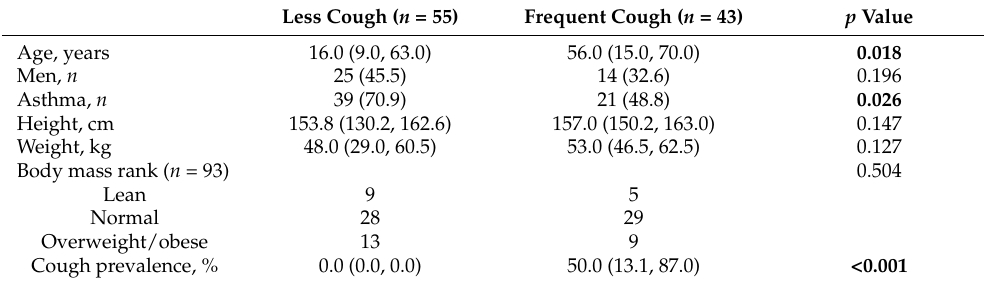
Table 2. Baseline characteristics of study participants according to the cough